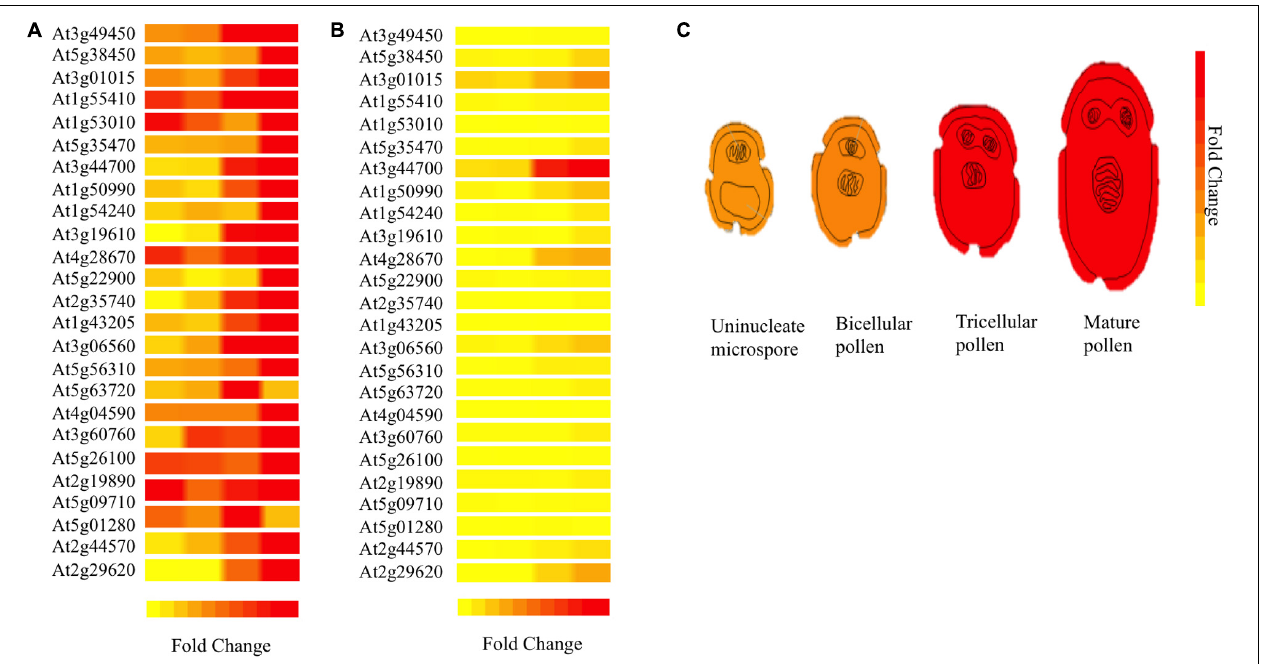
FIGURE 9 | Heat map of genes co-expressed with 3p.AtFBP113 in a tissue-specific manner. The part (A) of the figure shows the local expression patterns of genes co-express with candidate gene 3p.AtFBP113 (At3g49450) in the form of a heat map during different developmental stages of microgametogenesis. (B) Shows the global view of gene expression indicating strong differential expression of a gene during last stage of microgametogenesis. The color legend indicates the expression levels in the form of fold change, where red shows maximum and yellow represents minimum change. (C) Depicts the expression of 3p.AtFBP113 exclusively during different developmental stages of microgametogenesis. The gene expression is low during early phases while reaches to a high level during later stages of reproduction as indicated by the color legend of fold